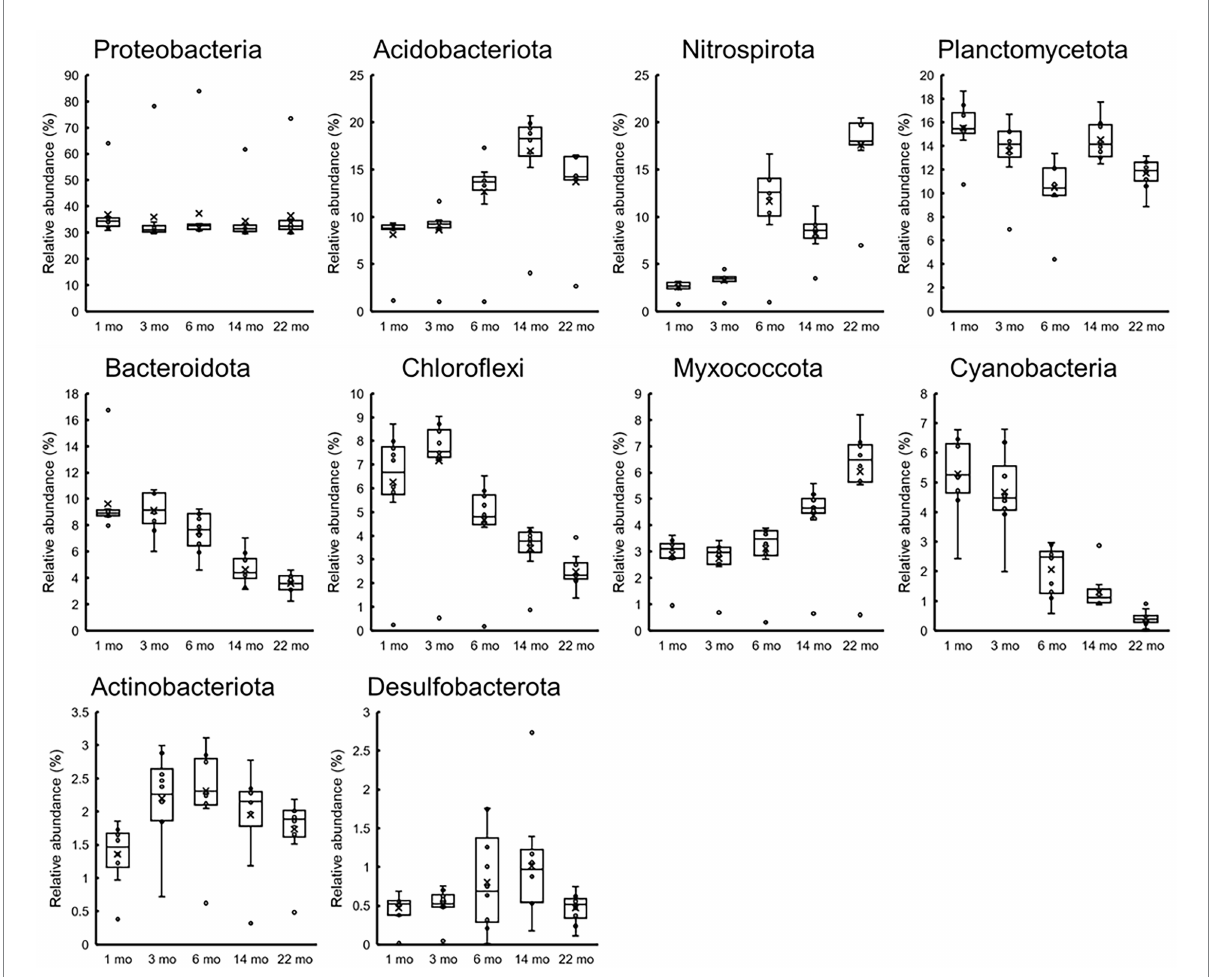
FIGURE 8 Temporal changes in 10 most abundant phyla. Relative abundances at the time of each sampling ( n = 10) are represented as box-and-whisker plots. The line in the middle of the box, top and bottom of the box, whiskers, and cross symbols represent the median, 25 and 75 percentiles, min-to- max values, and average,